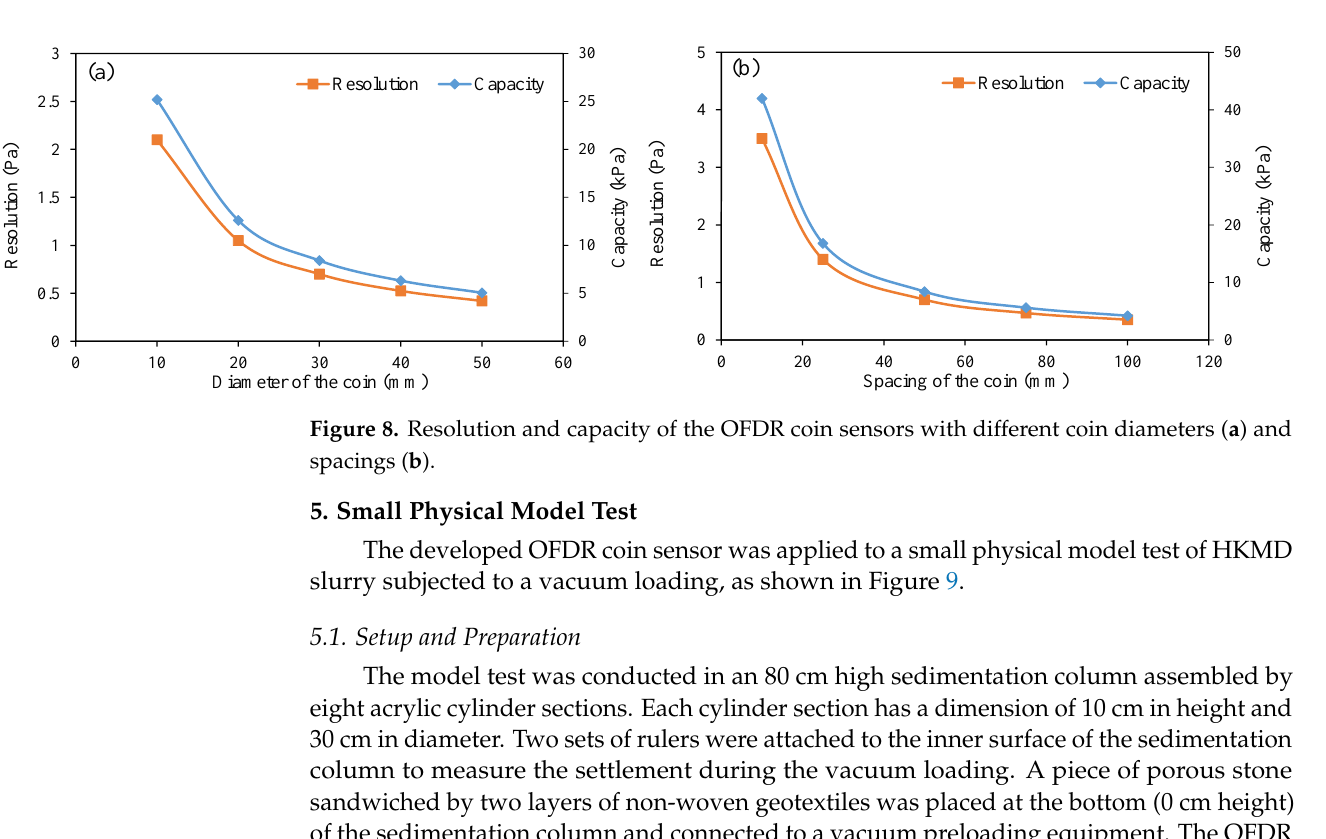
Figure 7. Calibration result.